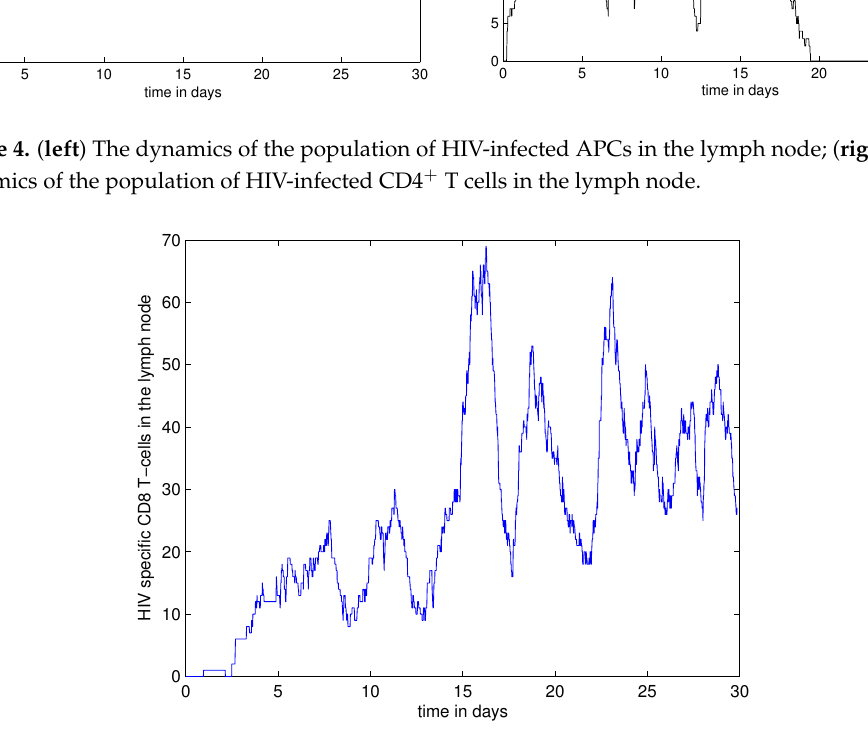
Figure 5. The dynamics of HIV-specific effector CD8 + T cell response in the lymph